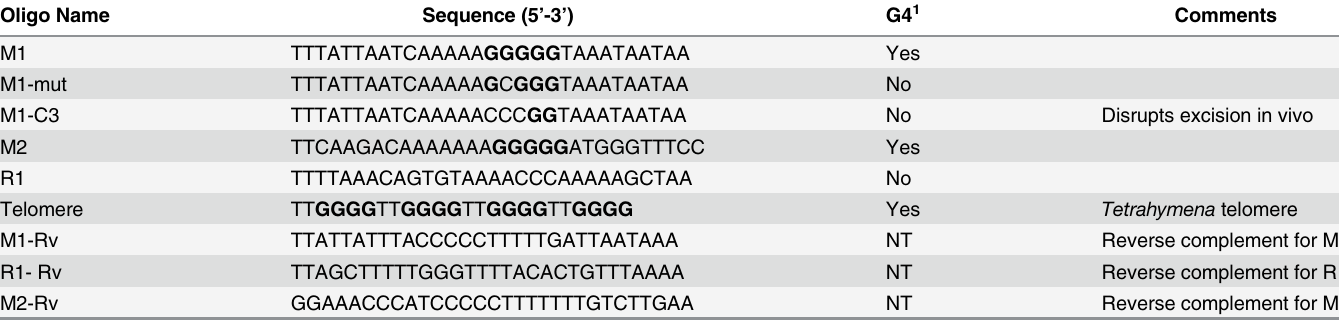
either 10 mM Tris-HCl (ph 7.5) alone or supplemented with either 100 mM KCl or 100 mM LiCl, then slow cooled to room temperature before native gel electrophoresis. The M1 oligonu- cleotide migrated as expected for ssDNA in buffer without salt or with LiCl, but abnormally